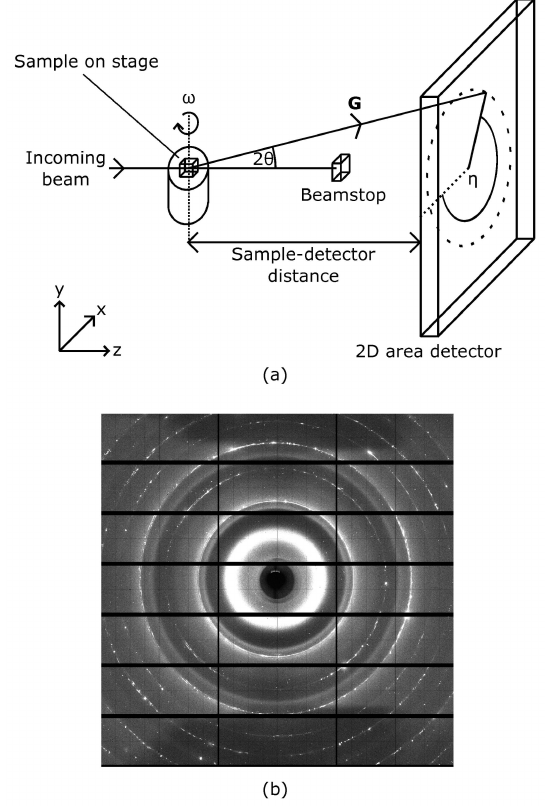
Figure 1 3DXRD experimental diagram ( a ) with a typical single-frame diffraction pattern from a 2D area detector ( b